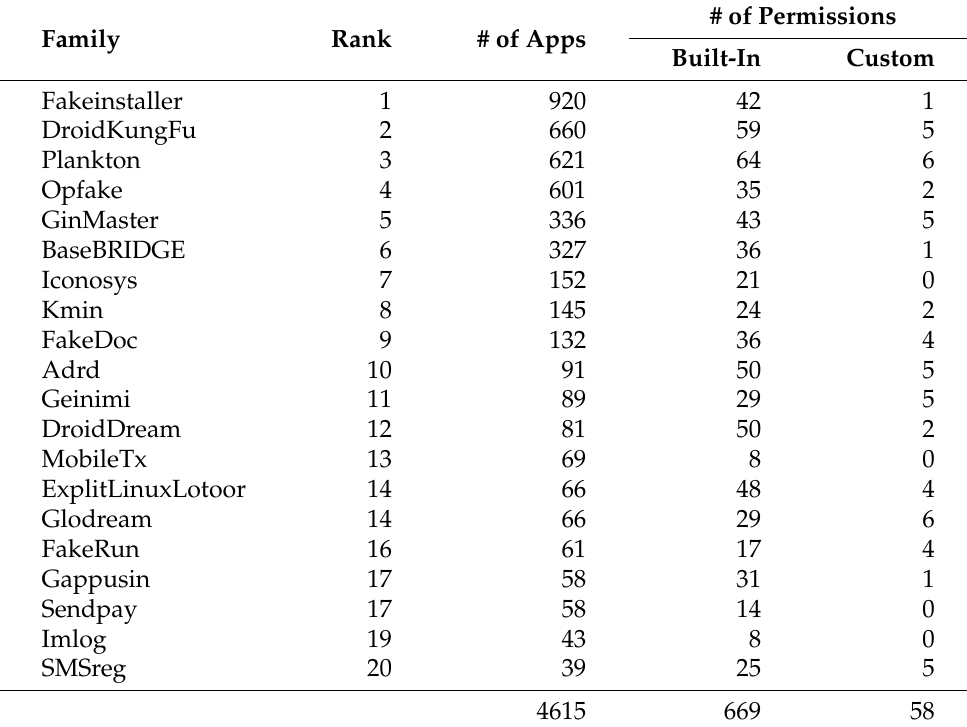
Table 1. The number of samples and permissions of the top 20